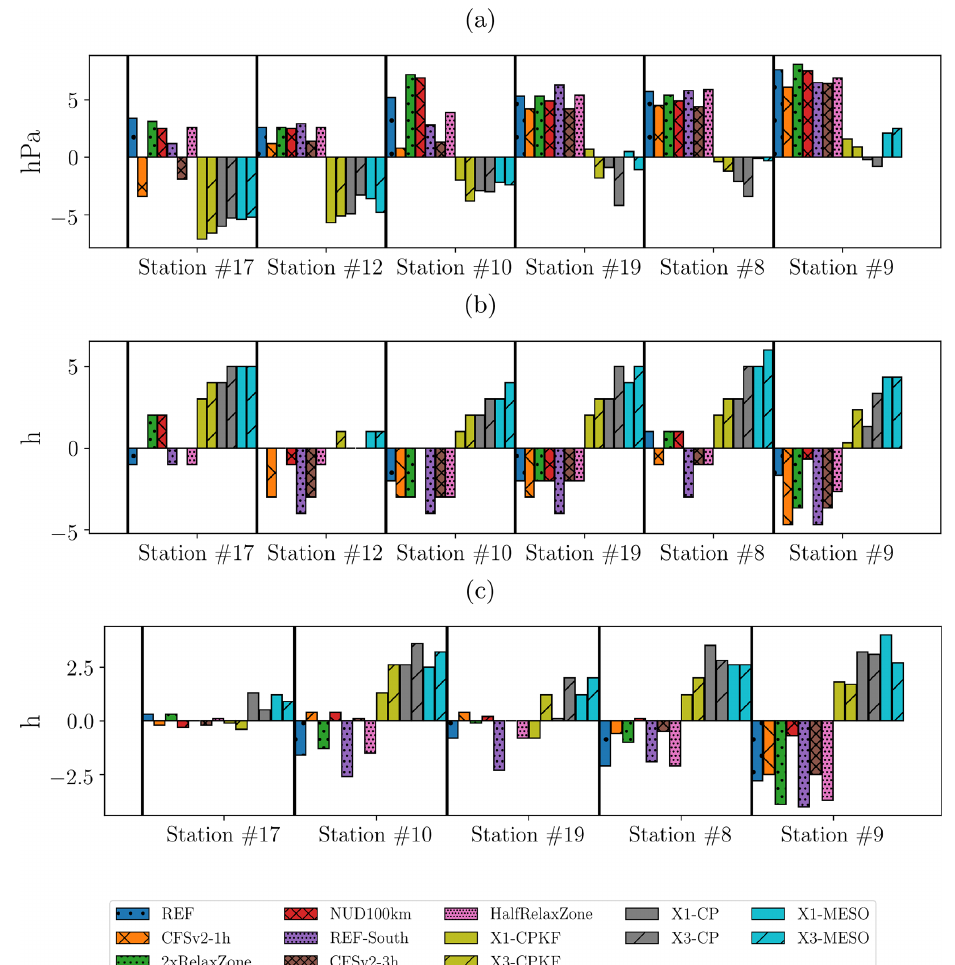
Figure 6. Difference in (a) storm intensity, (b) t LMSLP and (c) storm duration between the simulations and the buoy observations. The naming of the WRF and MPAS configurations follows the naming convention introduced in Tables 2 and 3,